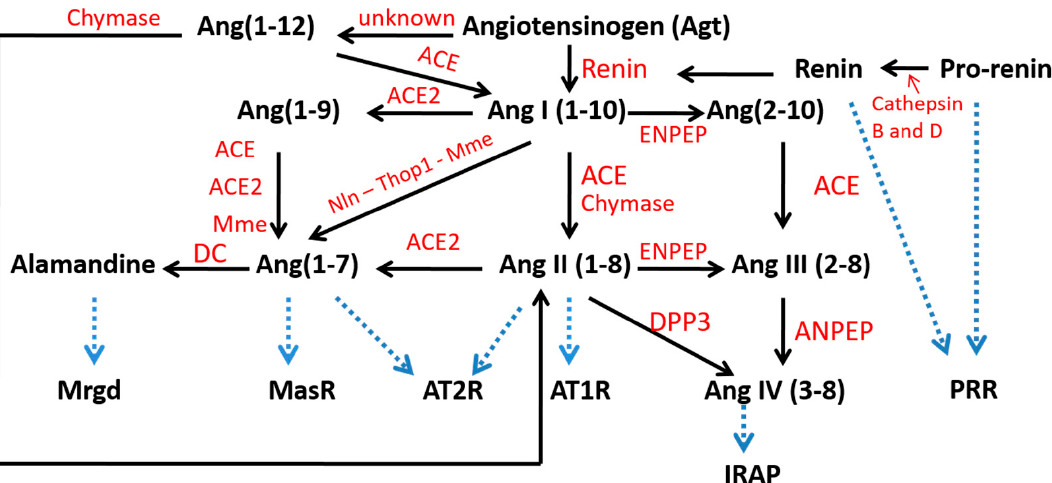
Figure 2. Non-classical RAS components. Renin is activated by its binding to the PRR receptor and enzyme cathepsin B and D. Renin cleaves the precursor protein angiotensinogen and enzymatic cascade of formed angiotensin peptides that bind with the different receptors T1R, AT2R, IRAP, MrgD and MasR and exert their effects. Angiotensin-converting enzyme (ACE) and angiotensin-converting enzyme 2 (ACE2), neurolysin (Nln), neprilysin (Mme), thimetoligopeptidase (Thop 1), angiotensin I receptor (AT1R), insulin-regulated aminopeptidase (IRAP), Mas-related G-protein coupled receptor member D (Mrgprd), pro-renin receptor (PRR), aminopeptidase A (ENPEP), aminopeptidase N (ANPEP), decarboxylation